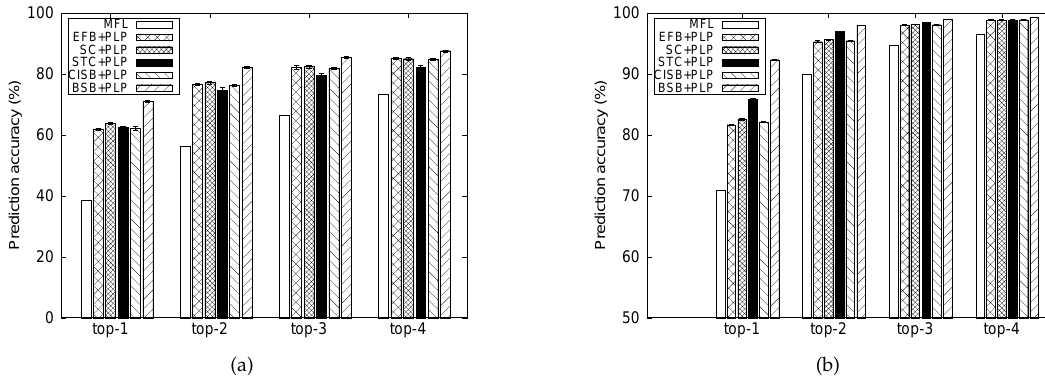
Figure 6. Top- k accuracy of the prediction model in case of ( a ) the MIT dataset and ( b ) Dartmouth